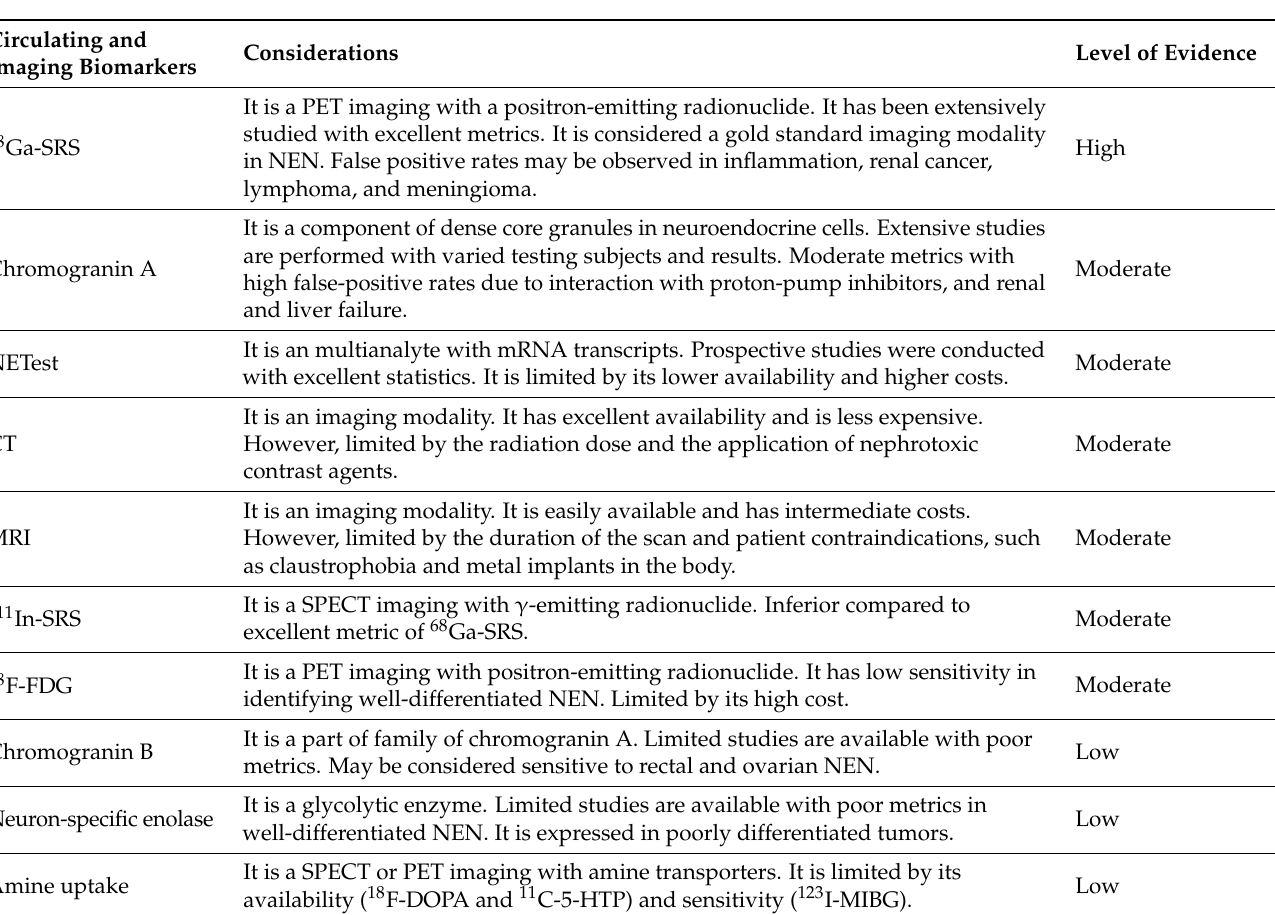
Table 3. Overview of biomarkers in NEN.